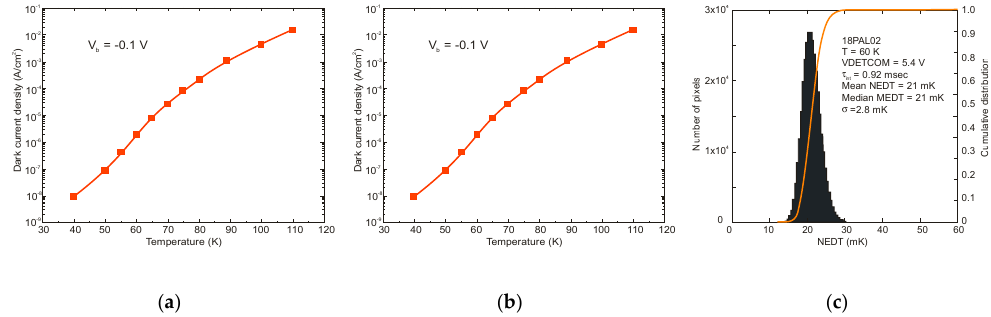
Figure 76. The LWIR ( λ cut-off = 11 μ m at 60 K) nBn T2SLs InAs/InAsSb photodetectors performance: ( a ) dark current density versus temperature for − 0.1 V, ( b ) BSI QE (no AR coating) measured for T = 60–75 K, ( c ) NEDT for 640 × 512 FPA for T = 60 K, 300 K blackbody temperature and f /4 cold stop (after [212]). The LWIR detector was used to fabricate 24 μ m pitch, 640 × 512 FPA and Lockheed Martin SBF- 193 ROIC. The measured 640 × 512 FPA NEDT histogram for T = 60 K, 300 K blackbody temperature and f /4 cold stop is shown in Figure 76c. The 21 mK NEDT is in fair agreement with the estimated NEDT based on a single element test detector data [212].